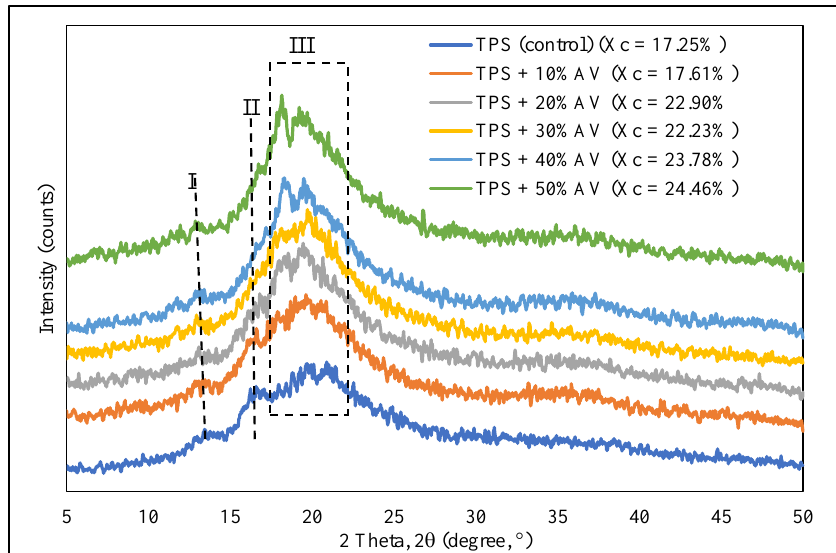
Figure 5. X-ray diffraction pattern of TPS film with different AV gel concentrations.